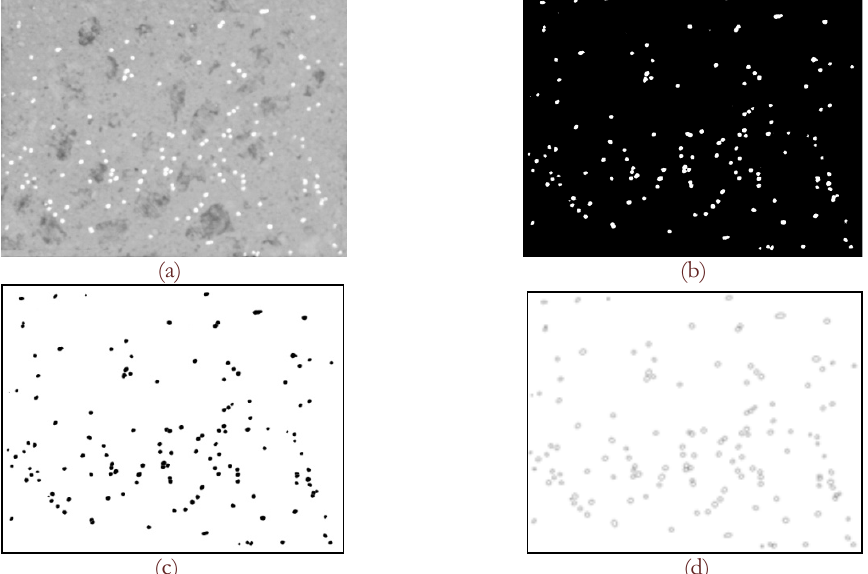
Figure 7: Image processing steps: (a) converting a colored image to greyscale image (b) adjusting a threshold, (c) defining mask, noise (remove small noises) and watershed (separated fibres that are stuck together) functions, (d) fitting the best ellipse to each